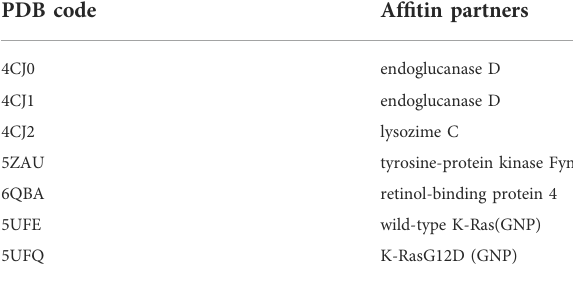
TABLE 1 Af fi tin-Protein complexes